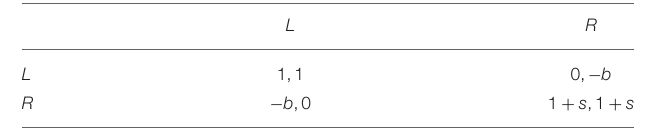
TABLE 1 | Payoff matrix for a two-person, two-strategy coordination